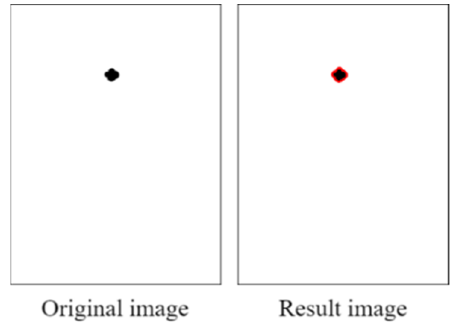
Figure 29. Results of the contour test.